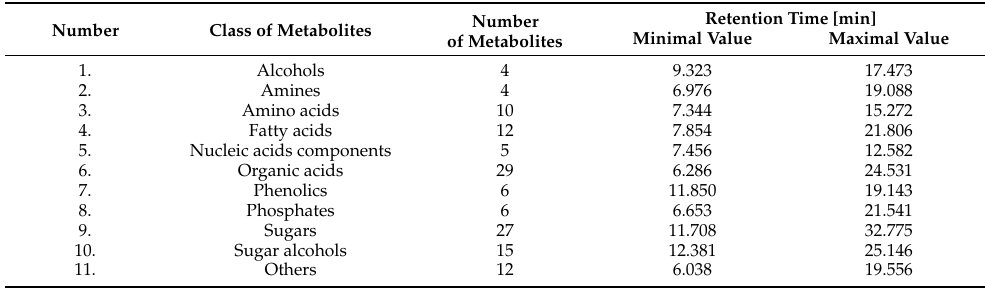
Table 1. The range of retention time of alphabetic list of groups of organic chemicals recognized in post culture liquid medium of Cyathea delgadii cell suspension